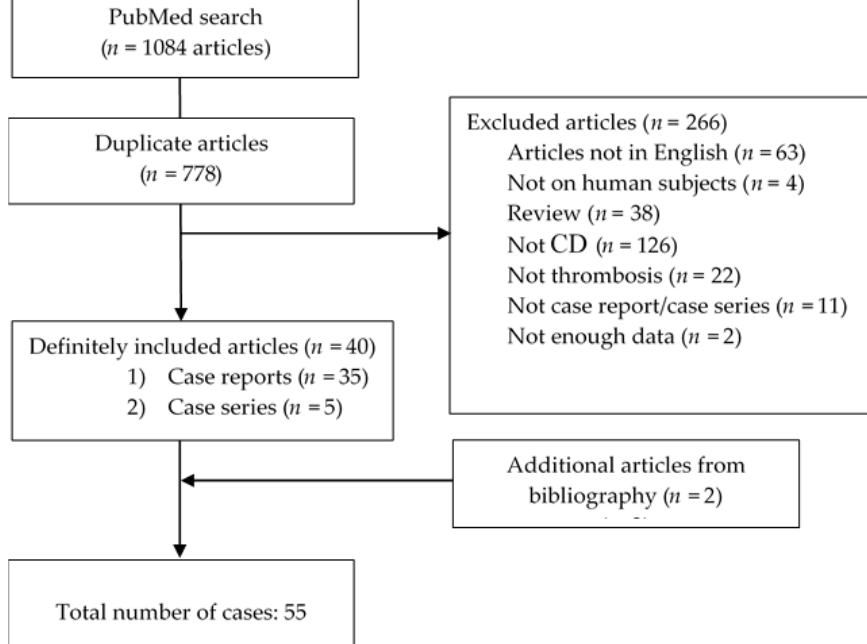
Figure 1. PRISMA flow chart.